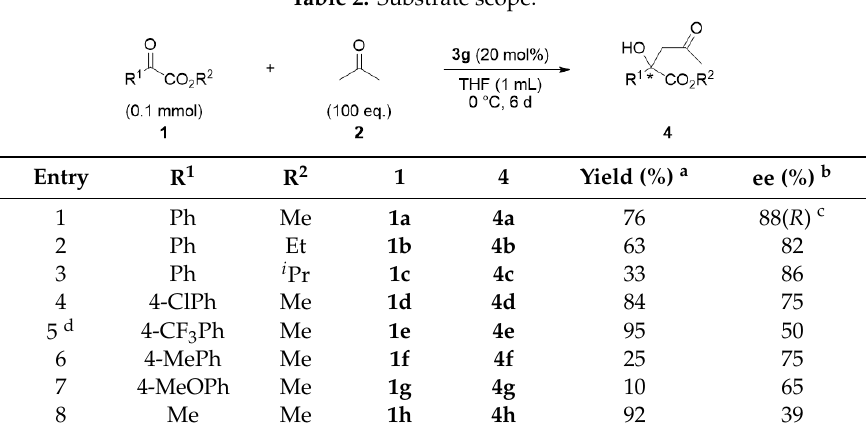
Table 2. Substrate scope.